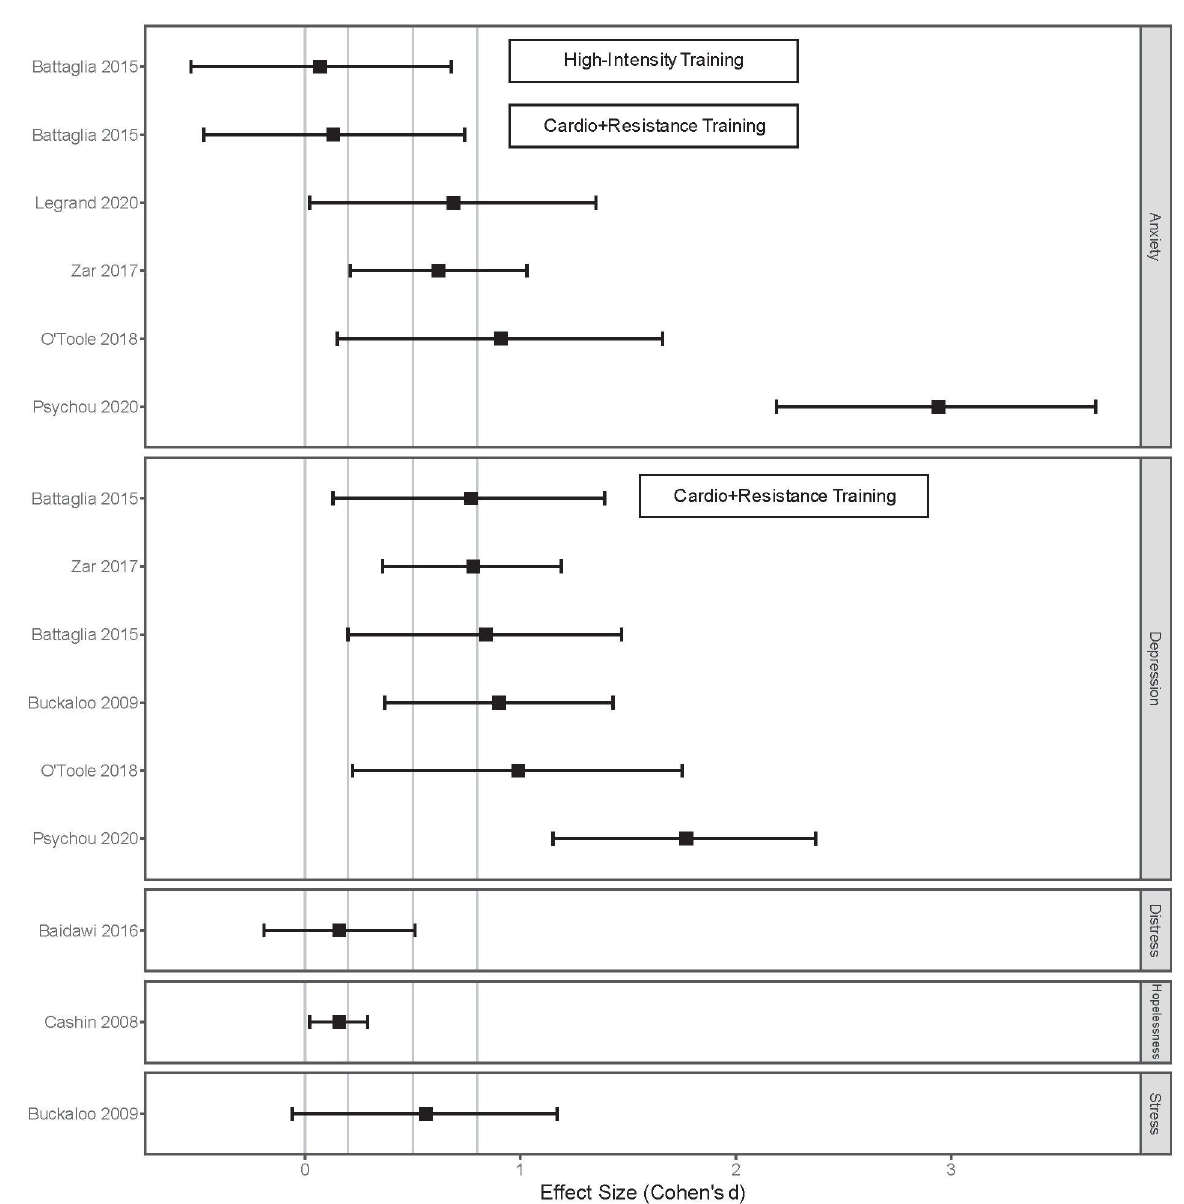
Fig 4. Effect size estimates for the impact of exercise on mental